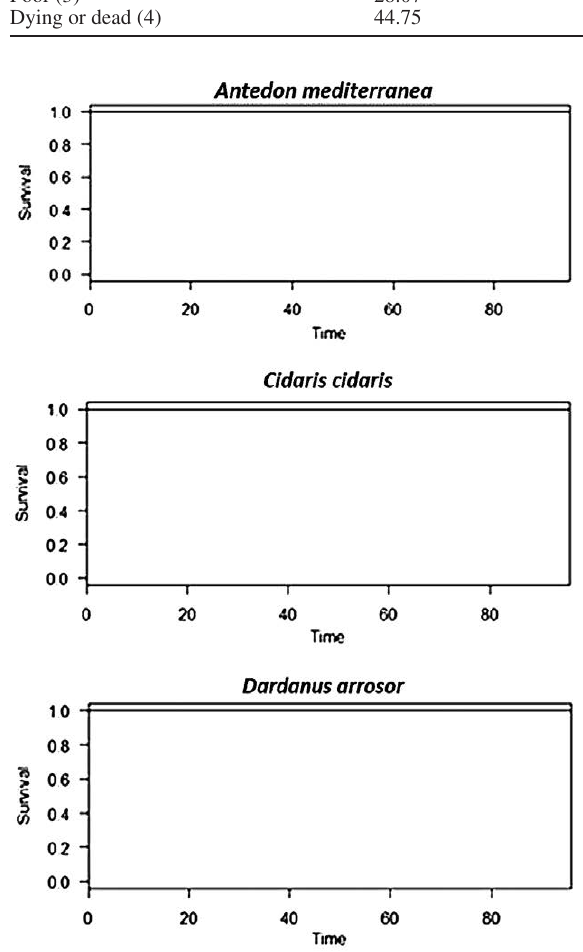
Fig. 2. – Analysis with the K-M model to assess the survival of Antedon mediterranea , Cidaris cidaris and Dardanus arrosor.